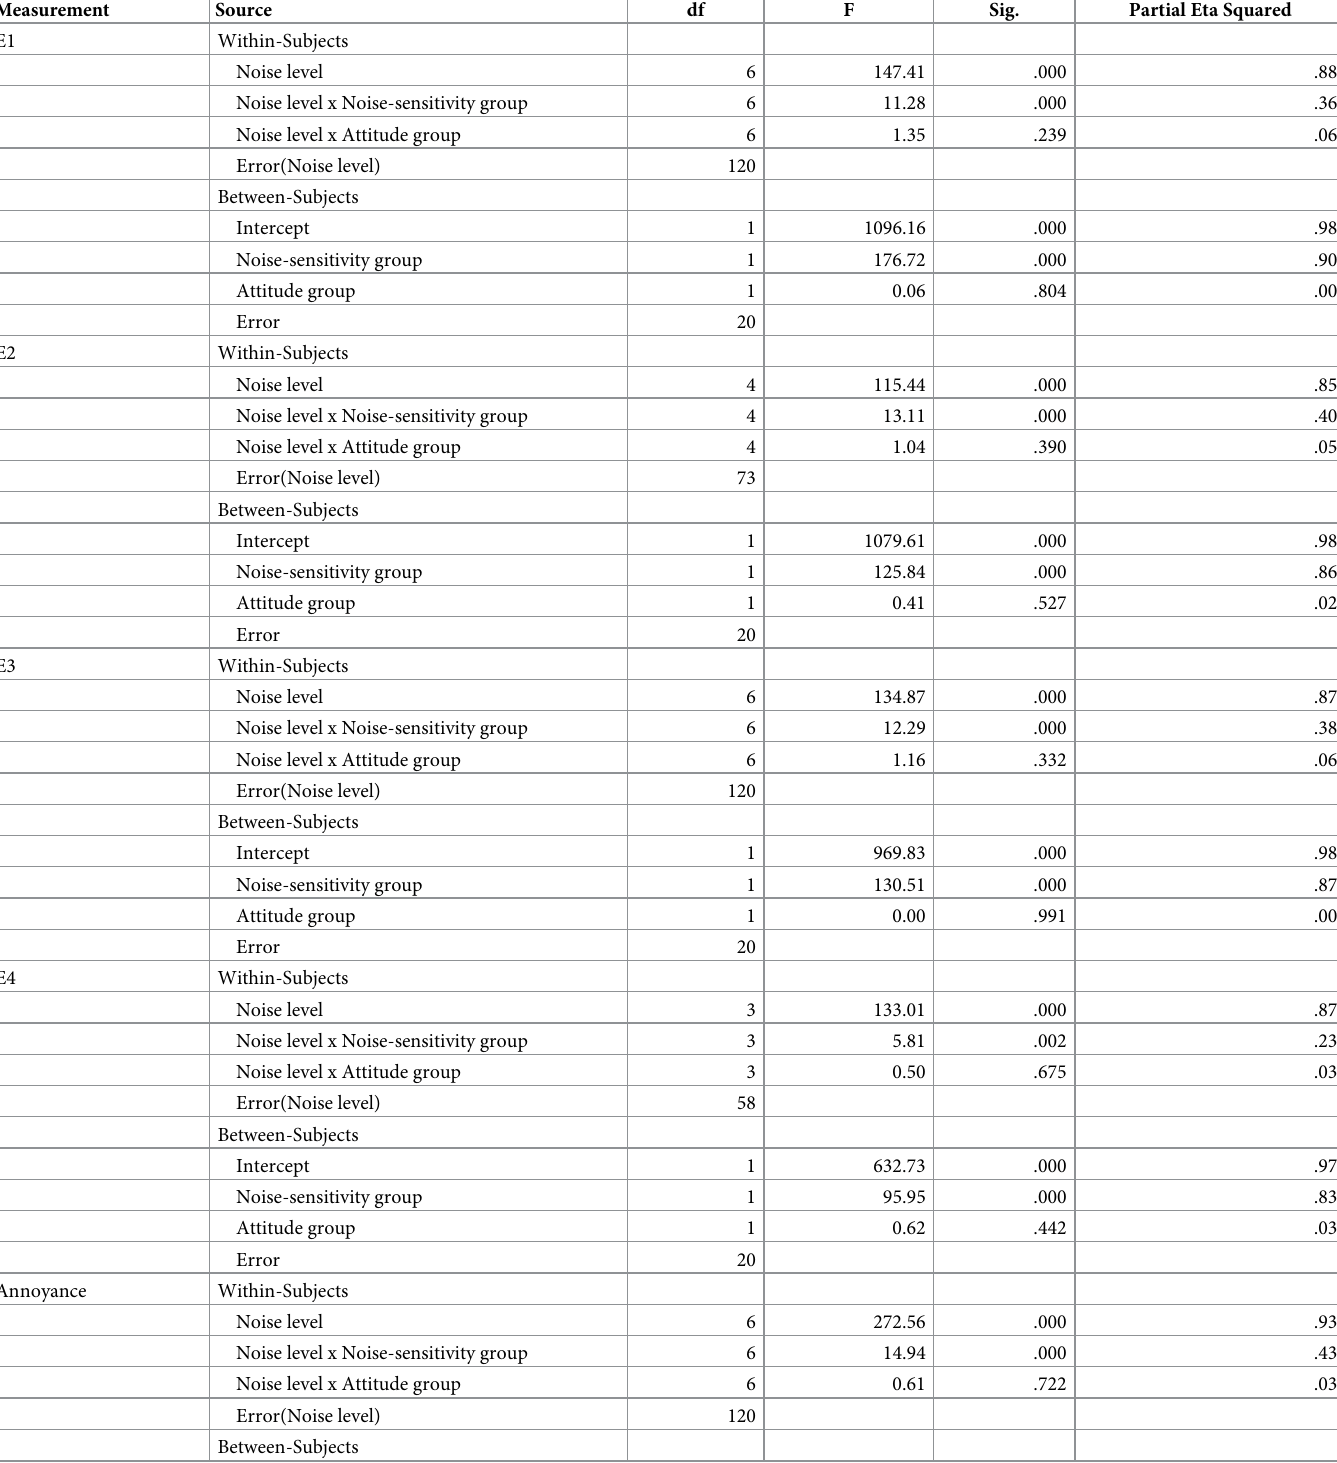
Table 7. Results of repeated-measures ANOVAs, with noise level as within-subjects factor, and noise-sensitivity groups and attitude groups as between-subjects factors.